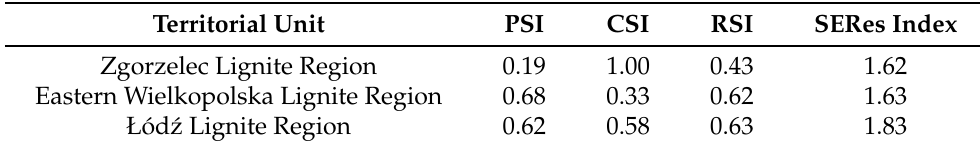
Table 4. Composite socio-economic resilience index (SERes) and sub-indices: PSI, CSI, and RSI in coal